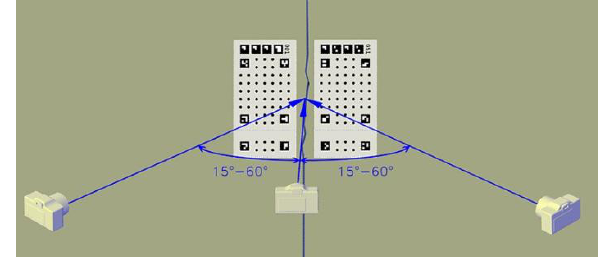
Figure 8. Stereophotogrammetric